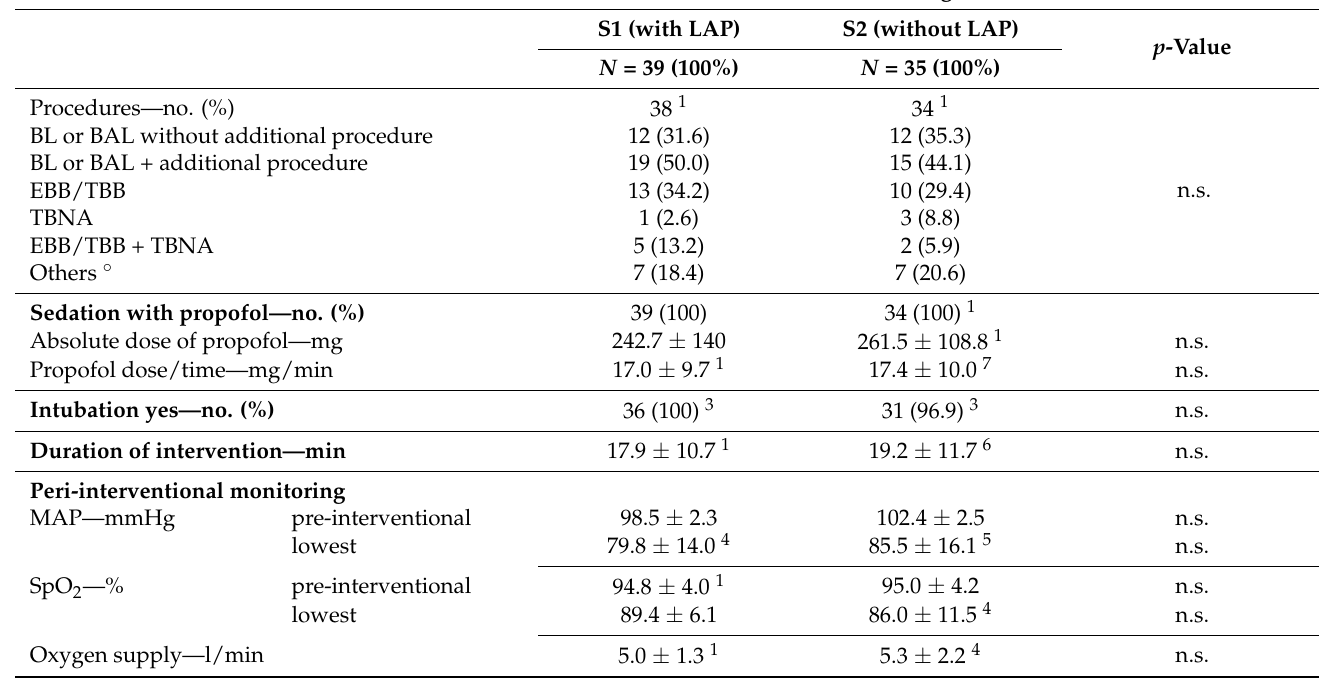
Table A2. Bronchoscopic interventions including procedures, medication and peri-interventional monitoring for the two groups—S1 (Standard 1 with LAP) versus S2 (Standard 2, without